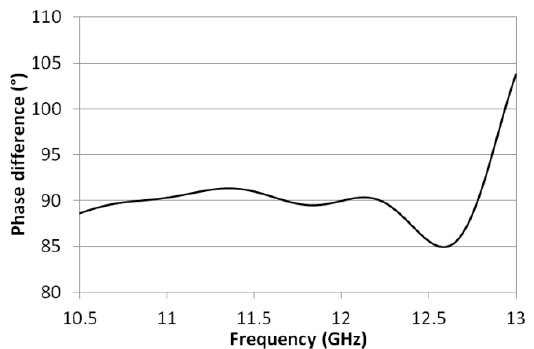
Figure 5. Comparison between simulated and experimental responses of the coupler in Figure 4. ( a ) Reflection coefficient and isolation; ( b ) Transmission coefficients. Figures adapted from [32].